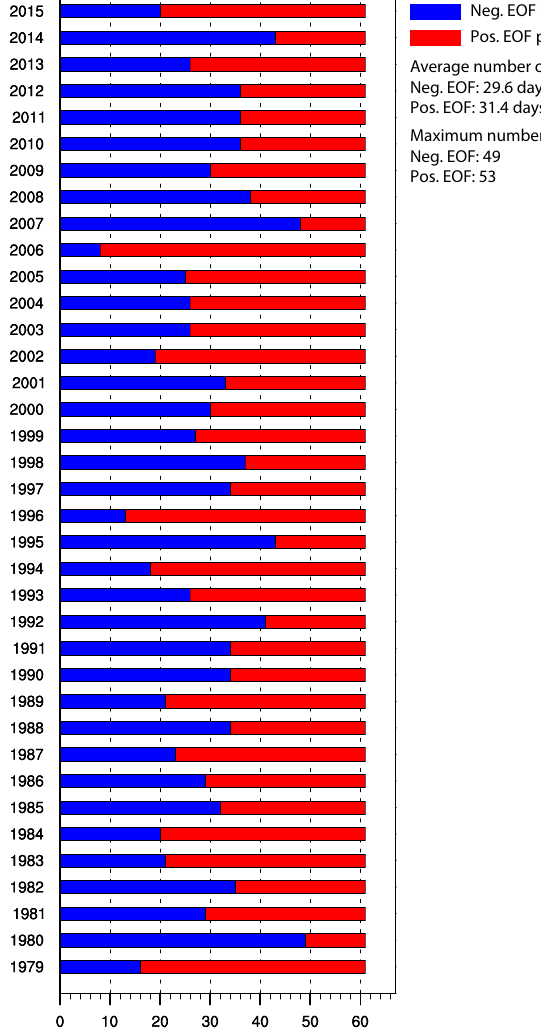
Figure 6. Statistics on the number of days identified as the nega- tive (respectively as the positive) first EOF phase during June–July period for each year during 1979–2015. EOF is calculated from 00:00UTC ERA-Interim 850hPa geopotential